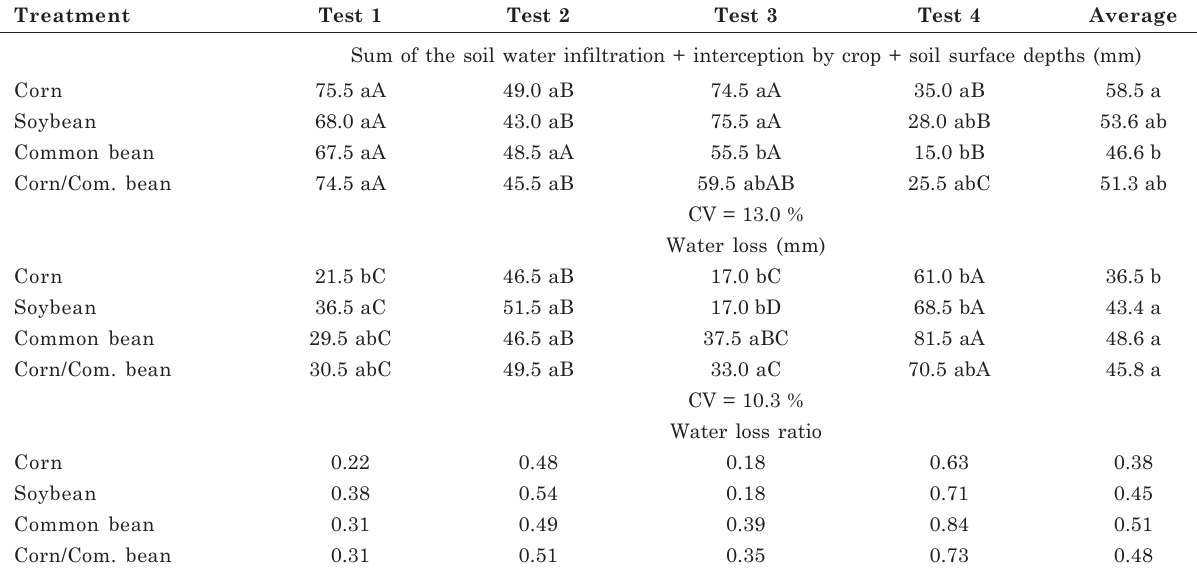
Table 3. Sum of the soil water infiltration + interception by crop + soil surface depths, and runoff depth adjusted for rainfall intensity of 64 mm h -1 and water loss ratio by runoff, under four treatments and rainfall tests, on a Humic Dystrudept soil